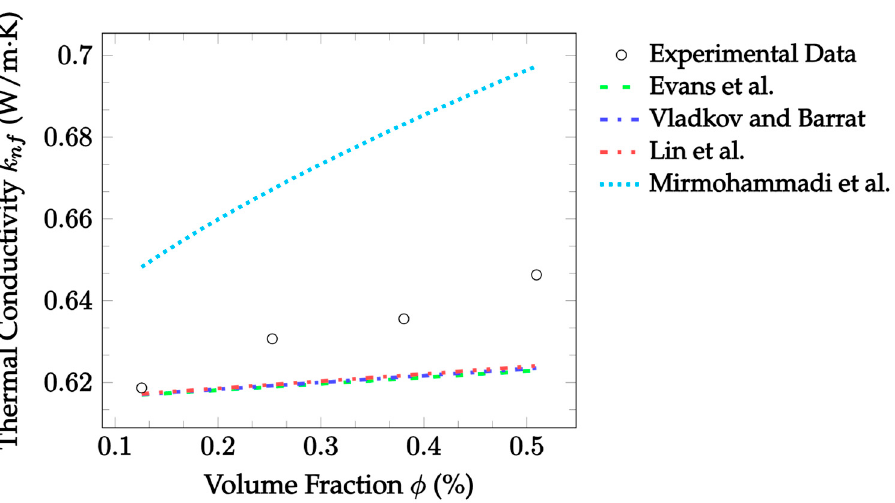
Figure 12. Molecular dynamics simulations compared with experimental data for 100 nm diameter Al 2 O 3 nanoparticles in water at T = 30 °C, with volume fractions between 0.126 and 0.5%: Experi- mental data [79], Evans et al. [33], Vladkov and Barrat [34], Lin et al. [35], Mirmohammadi et al. [36]. Table 5. Level of accuracy (%) of each MDS model when compared against given experimental data.